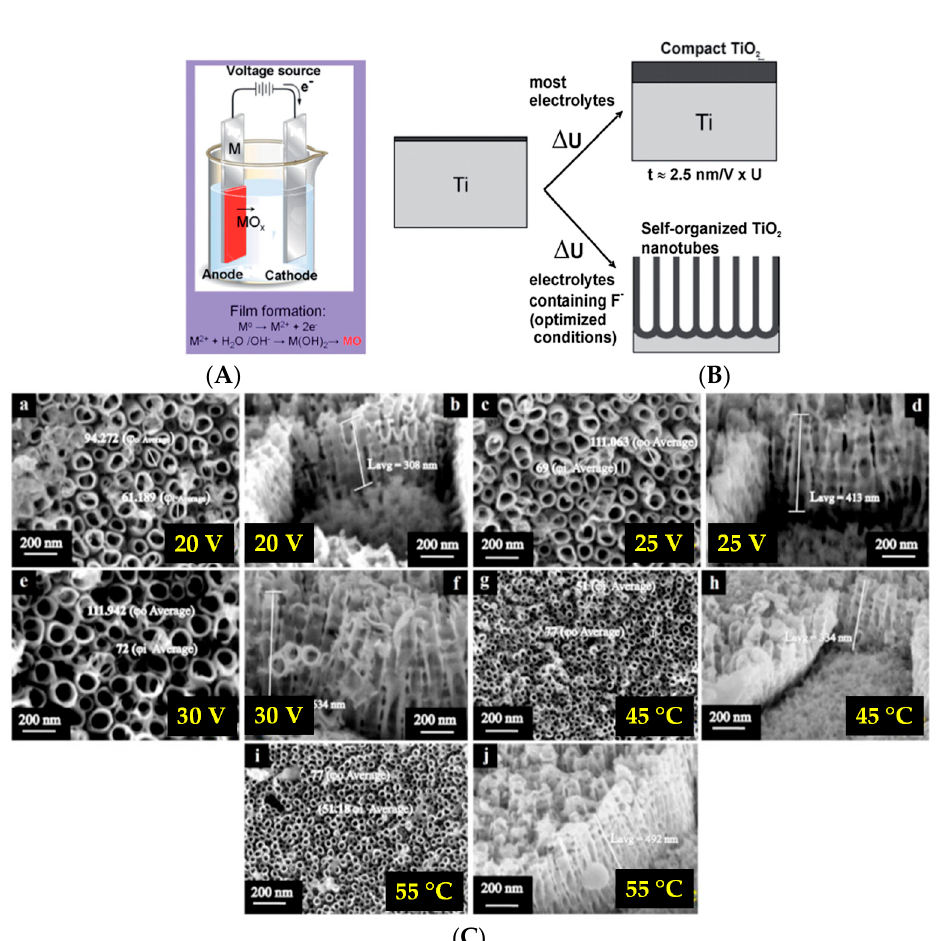
Figure 8. ( A ) Scheme illustrating the anodizing setup used to grow passive Ti oxide layers on Ti or Ti alloys. ( B ) A barrier layer or porous nanotubular layer can be obtained depending on the electrolyte’s nature. Reprinted from [82], copyright (2007), with permission from Elsevier. ( C ) FE-SEM micrographs of NTs diameter and length on Ti–6Al–4V at ( a , b ) 20 V, ( c , d ) 25 V, ( e , f ) 30 V at 30 ◦ C, ( g , h ) 20 V at 45 ◦ C, and ( i , j ) 20 V at 55 ◦ C. Reprinted from [83], copyright (2020), with permission from